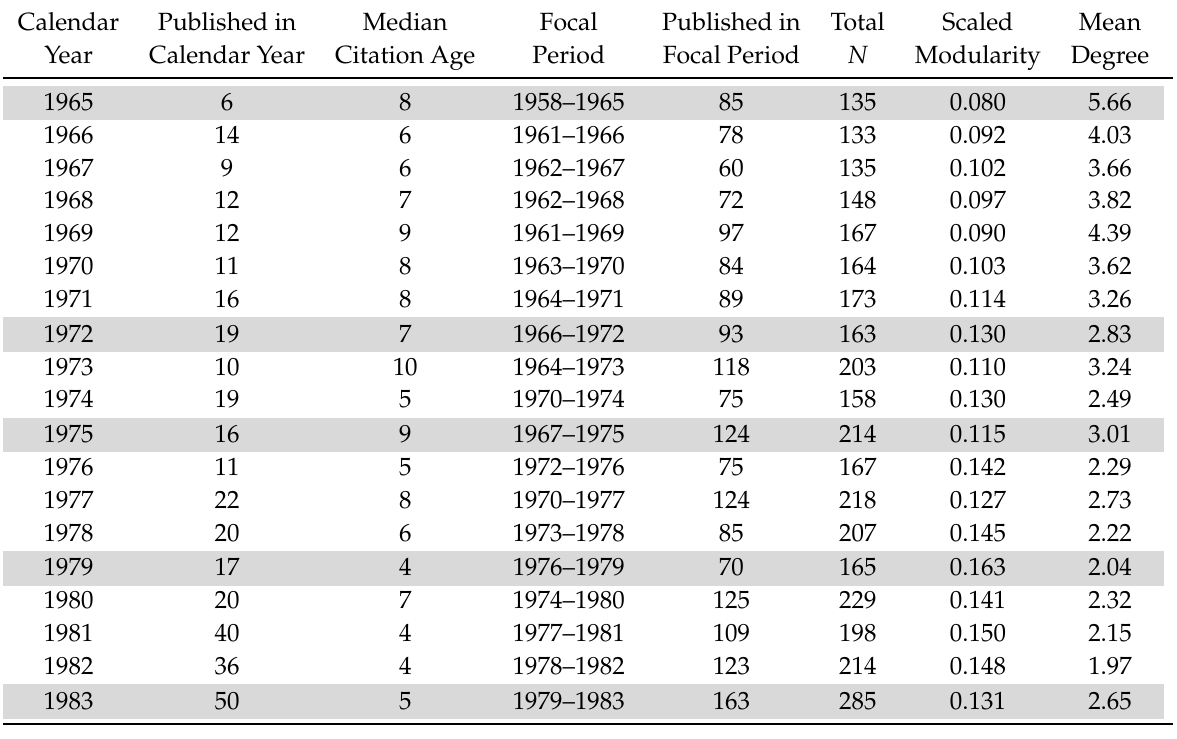
Table 1: Properties of Dynamic